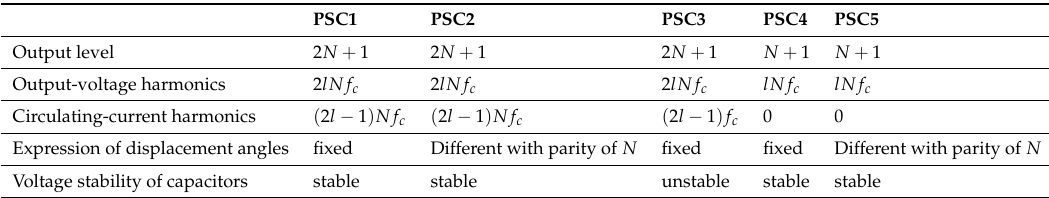
Table 2. Comparison of five PSC-SPWM